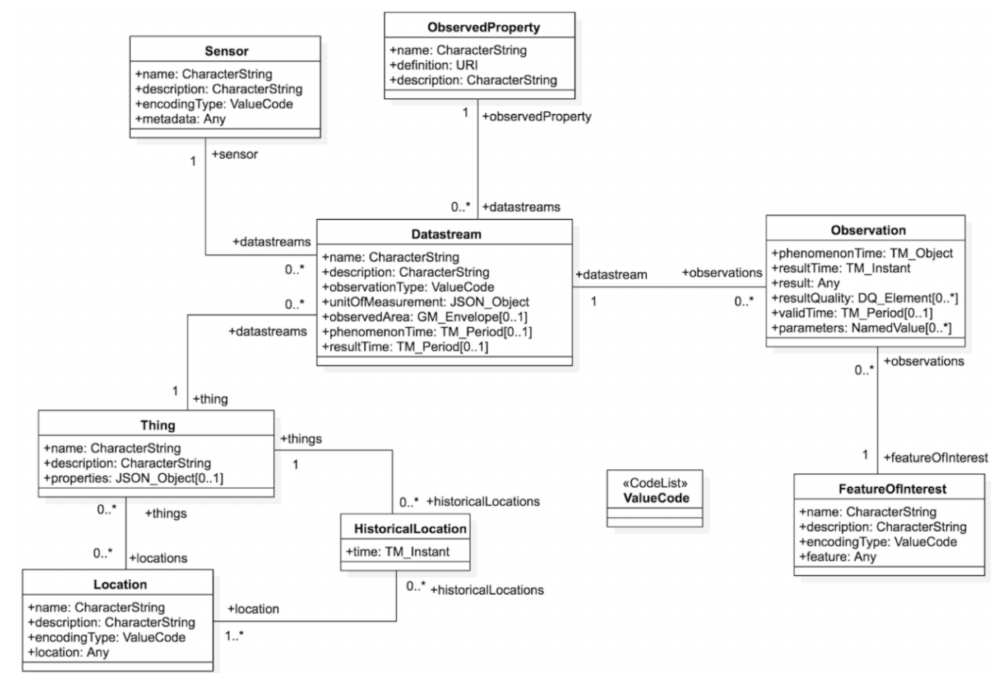
Figure 5. SensorThingsAPI (application programming interface) entity-relationship schema